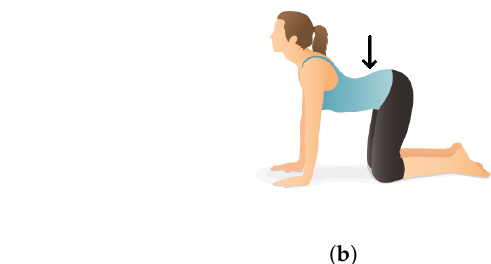
Table 2. Result of pitch, roll, and yaw static measurements with their respective error at different angles.